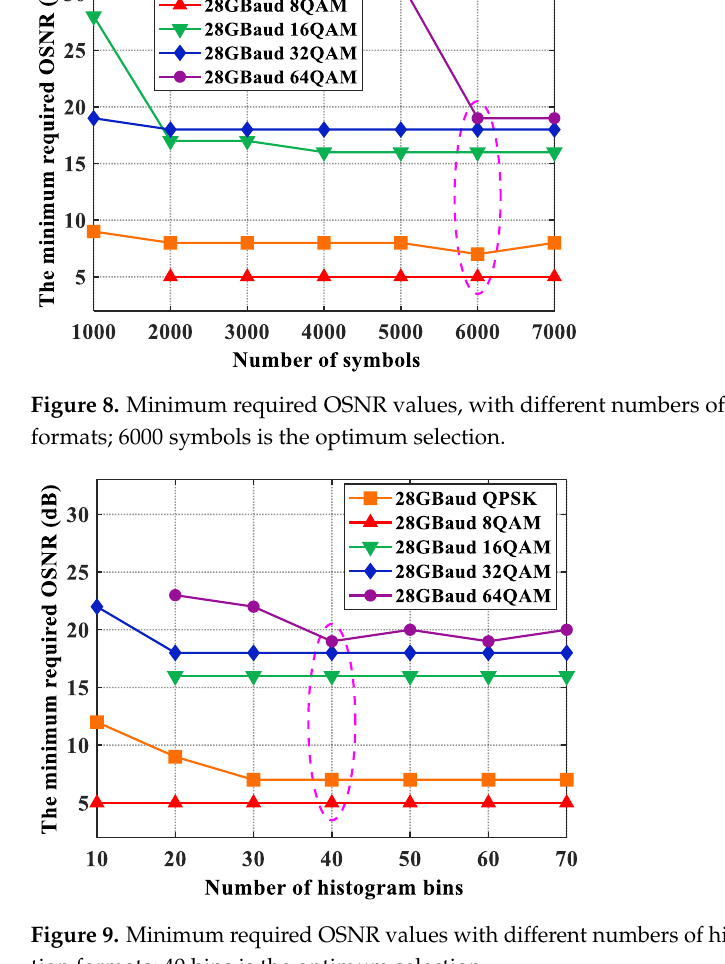
Figure 8. Minimum required OSNR values, with different numbers of symbols for five modulation formats; 6000 symbols is the optimum selection.